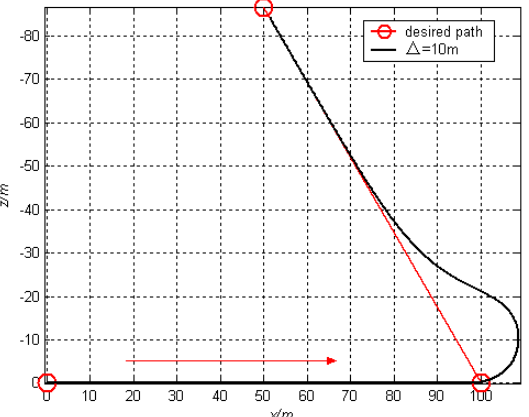
Figure 14. Following the triangular path with lookahead-based LOS.